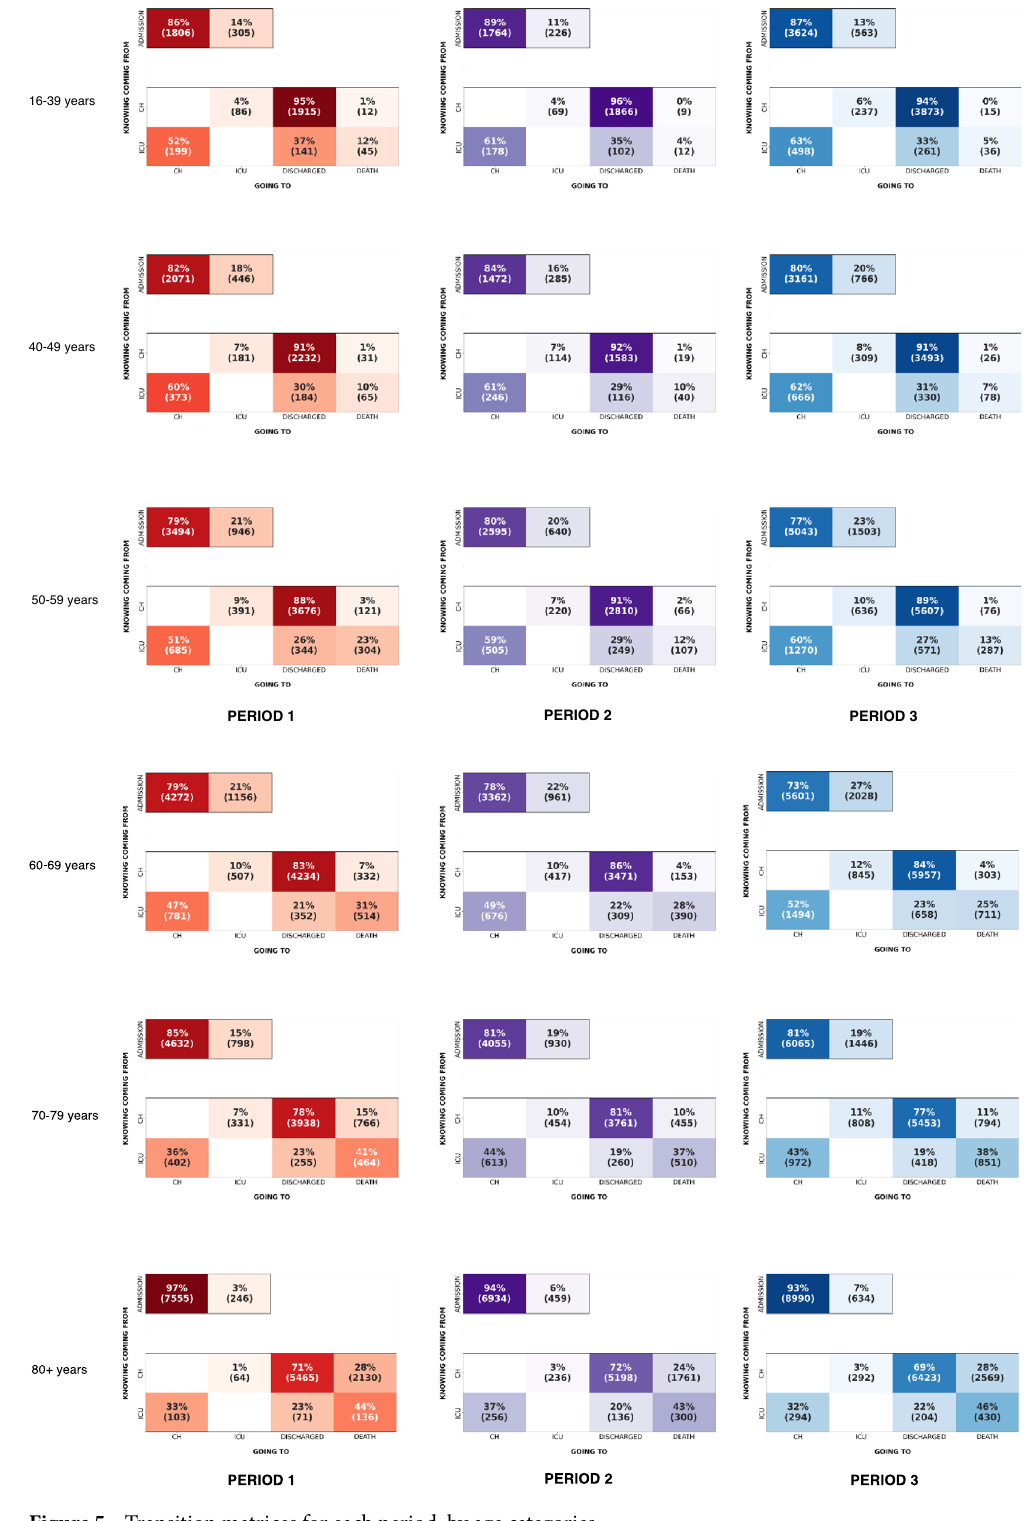
Figure 5. Transition matrices for each period, by age